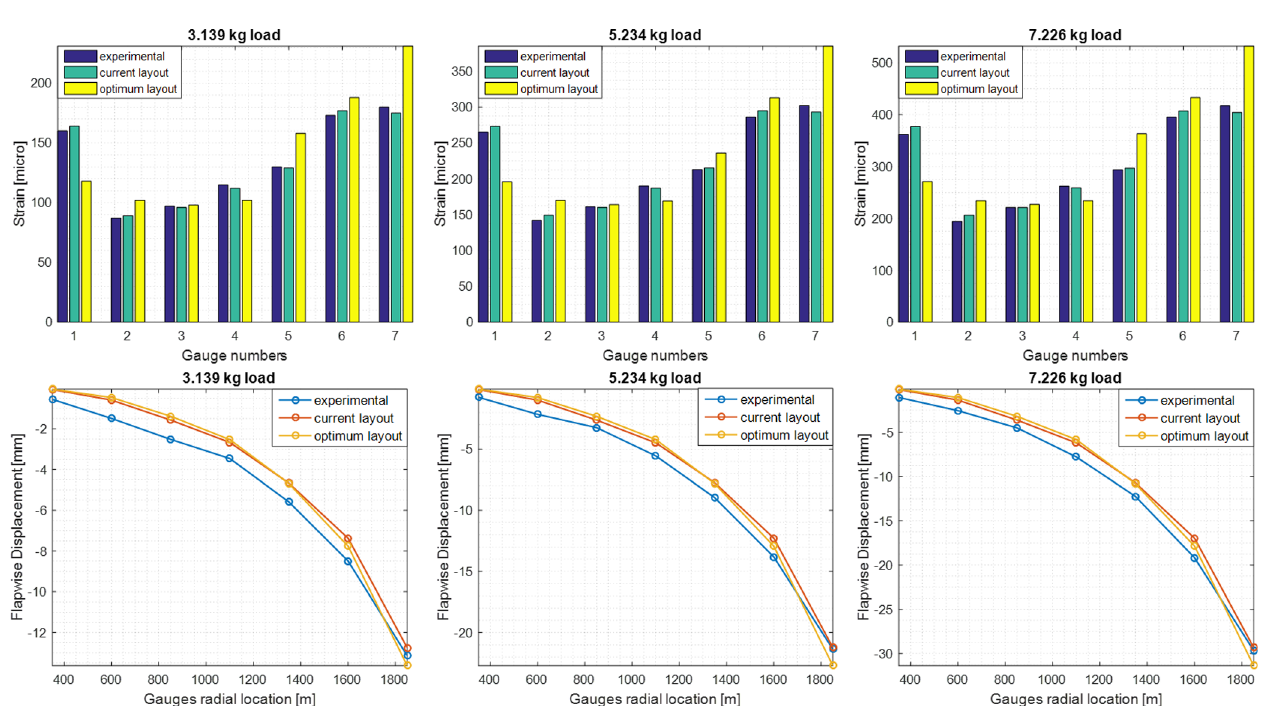
Fig. 6. Experimental data and FEA results from current blade layout and optimised